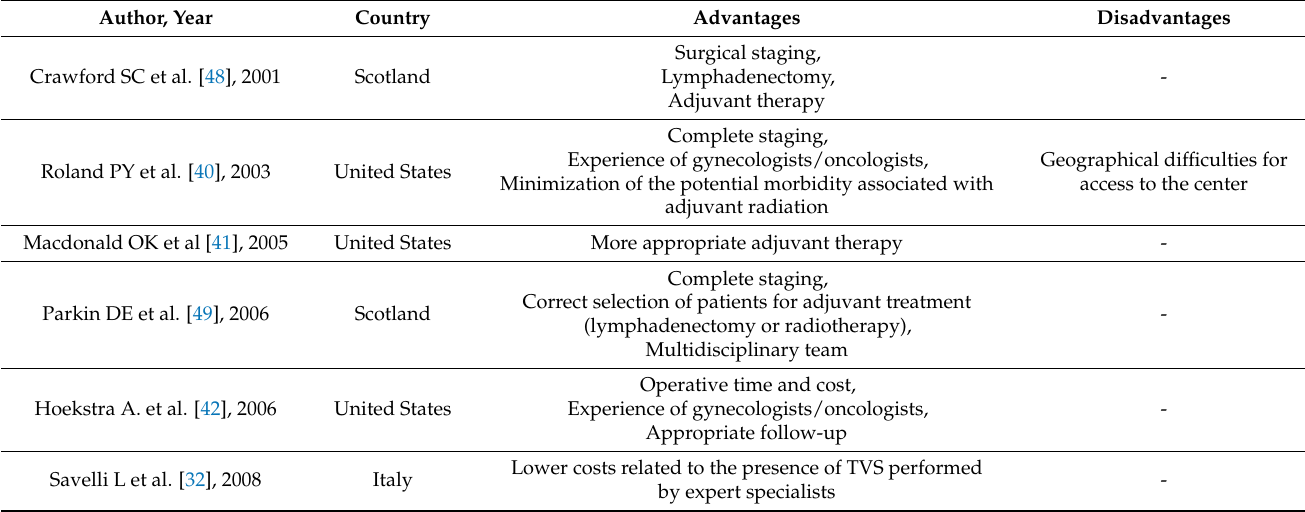
Table 1. Advantages and disadvantages of centralizing endometrial cancer